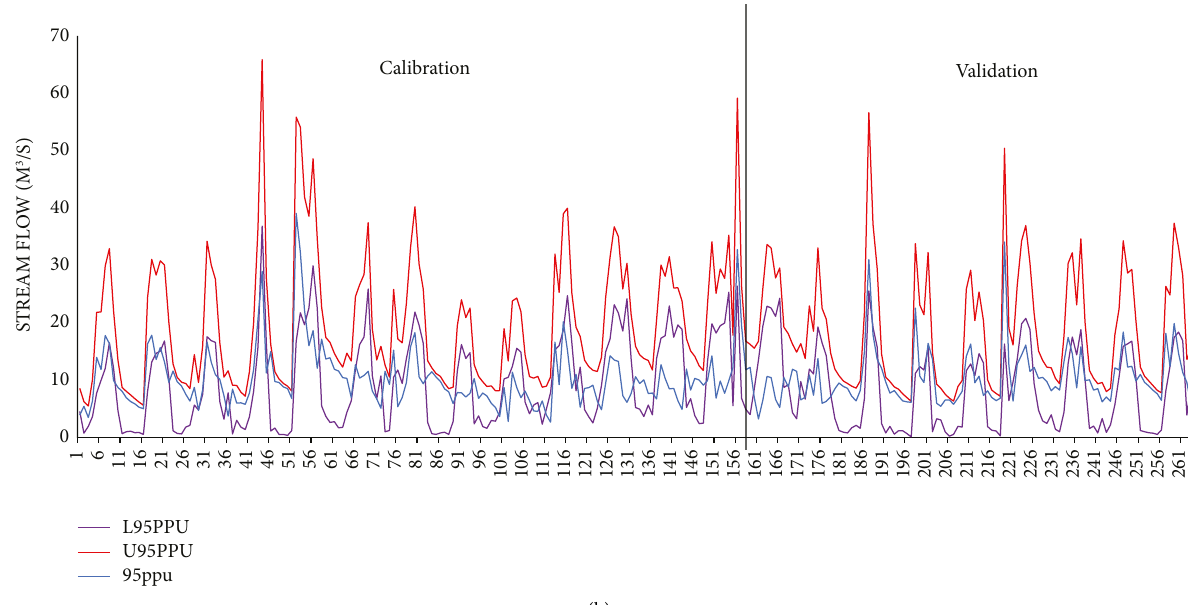
Figure 9: Daily streamflow of the Nashe watershed in calibration and validation periods. (a) Observed and simulated. (b) 95PPU plot.